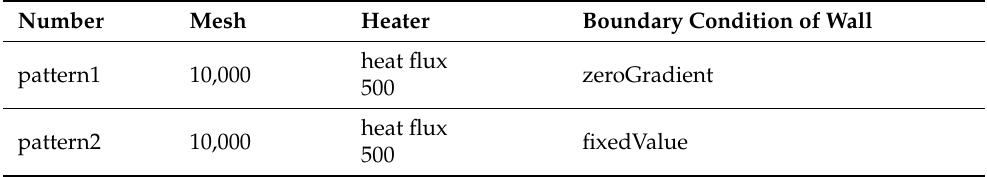
Table 9. Parameters values before proposal.